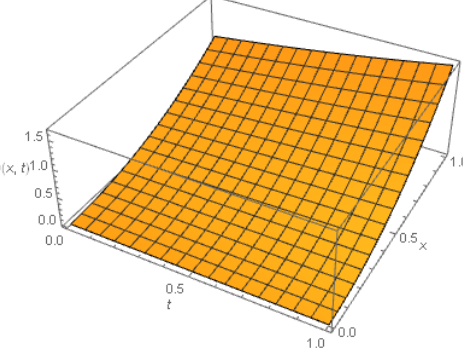
Figure 2:3D approximate Solution of example1 with (cid:11) = 1